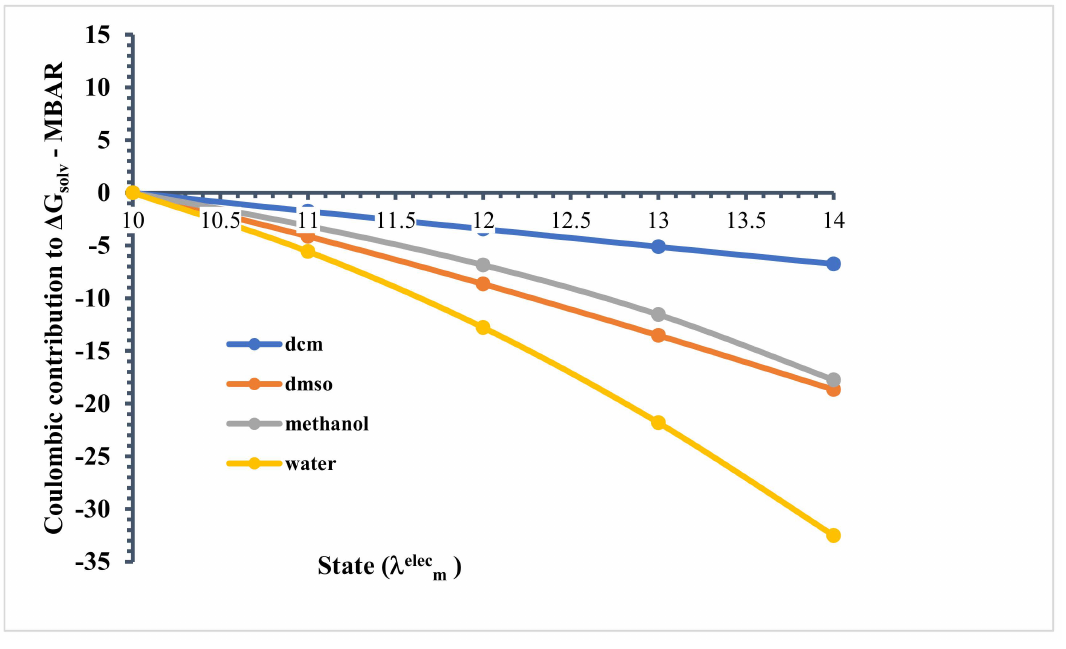
Figure 10. Contribution of electrostatic interaction at each stage of the ∆ G solv calculation (MBAR).